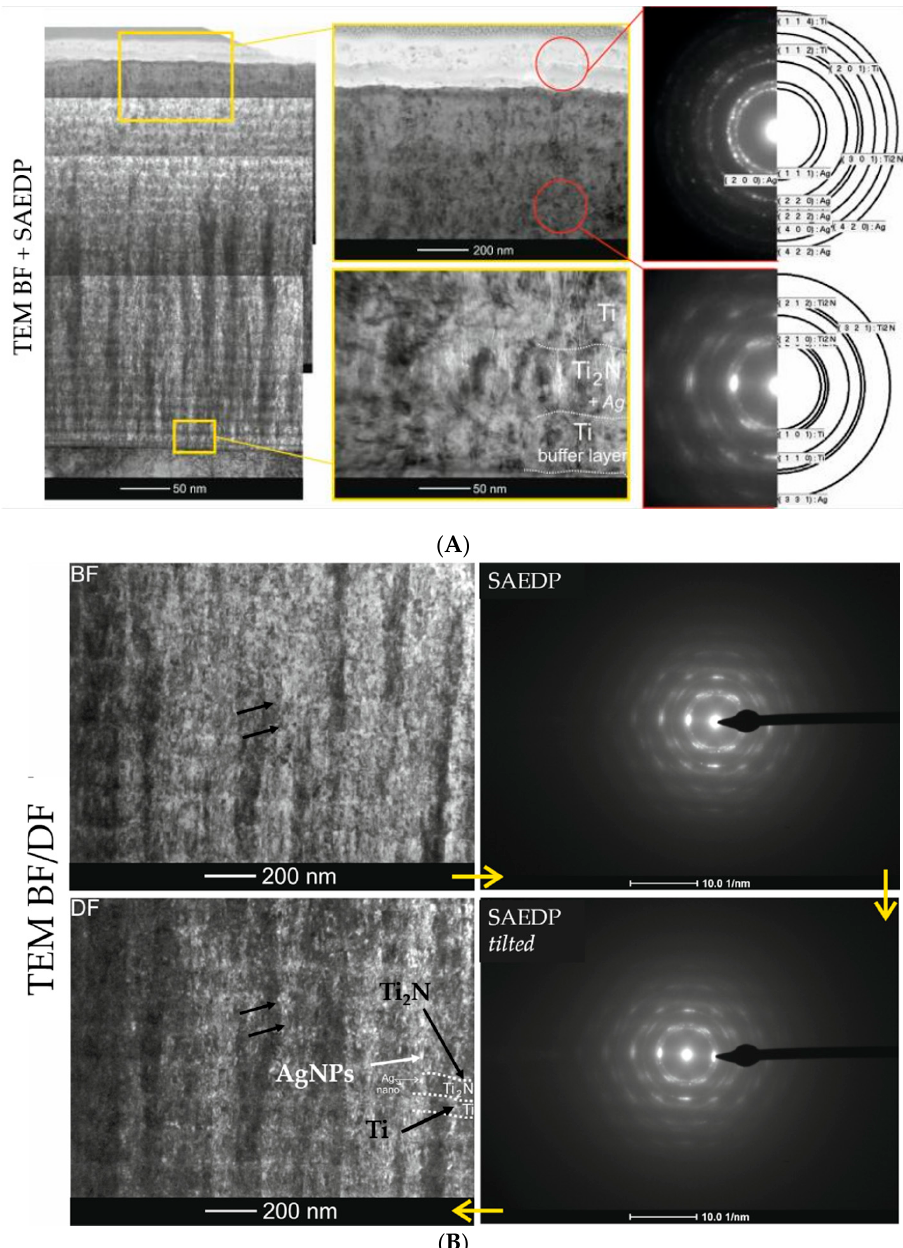
Figure 1. TEM/BF images and accompanying electron diffractions: ( A ) of multi-layer Ti/Ti x N coating with thickness (~3.80 µm) implanted with Ag nanoparticles (12.5% at.), ( B ) of Ag nanocrystallites in both Ti and Ti 2 N layers.